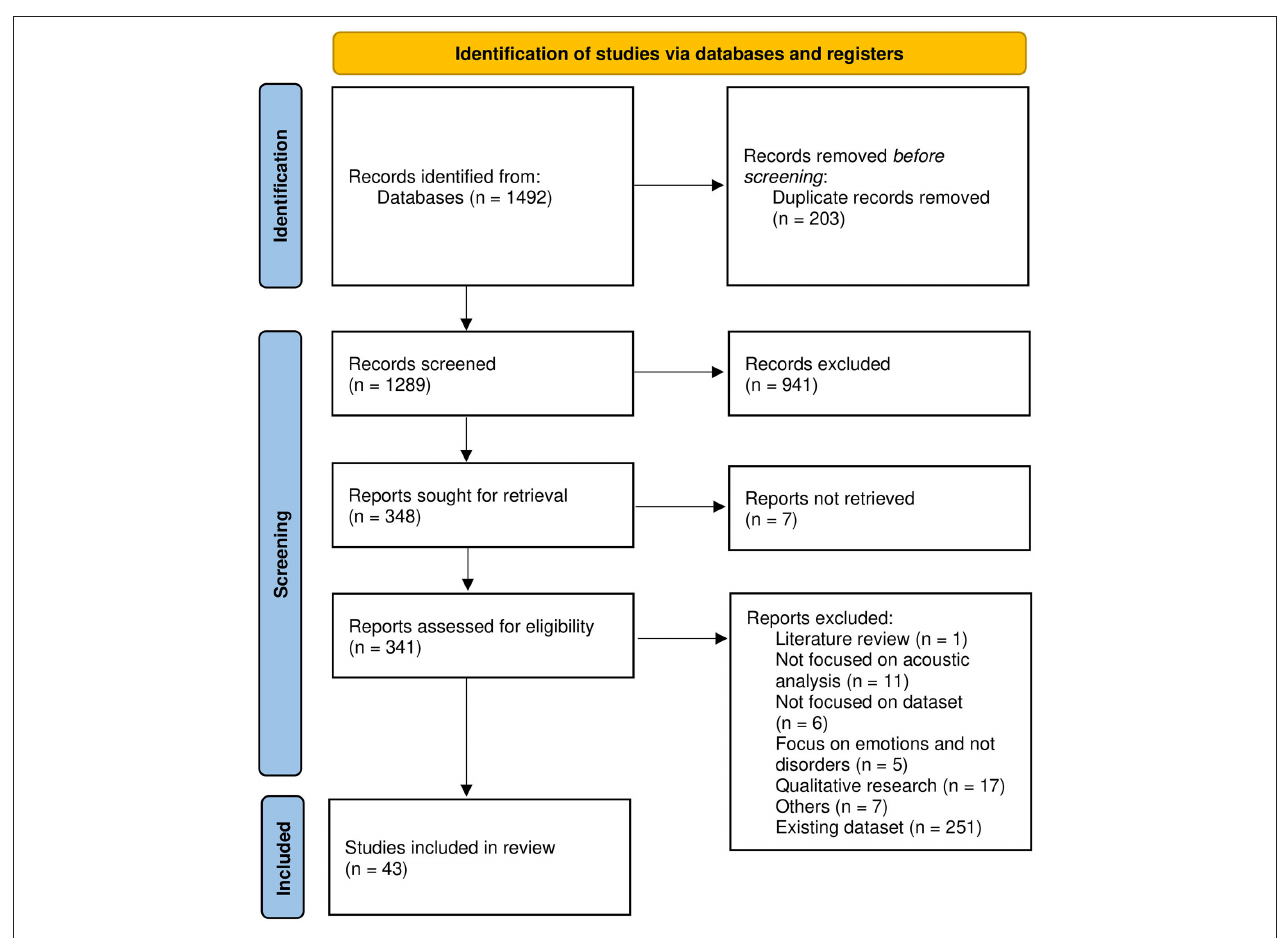
FIGURE 2 | PRISMA flow chart for study selection.